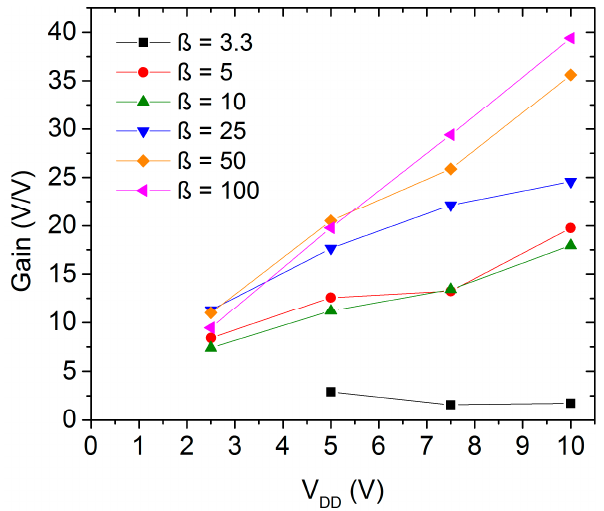
Figure 8. Average gain of the ZnO nanoparticles inverters in dependence on the supply voltage.